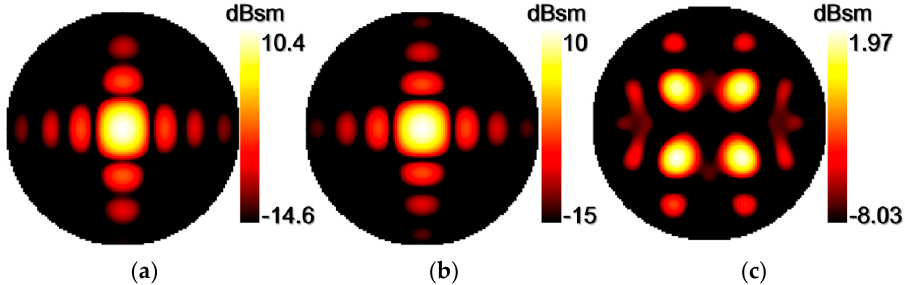
Figure 3. Simulated 3D scattering patterns for a metal plate, the CFMS of all “0” units and the CFMS with checkerboard structure with the same area at 4.79 GHz. ( a ) 3D scattering pattern of a metal plate. ( b ) 3D scattering pattern for the CFMS of all “0” units. ( c ) 3D scattering pattern of the CFMS with checkerboard